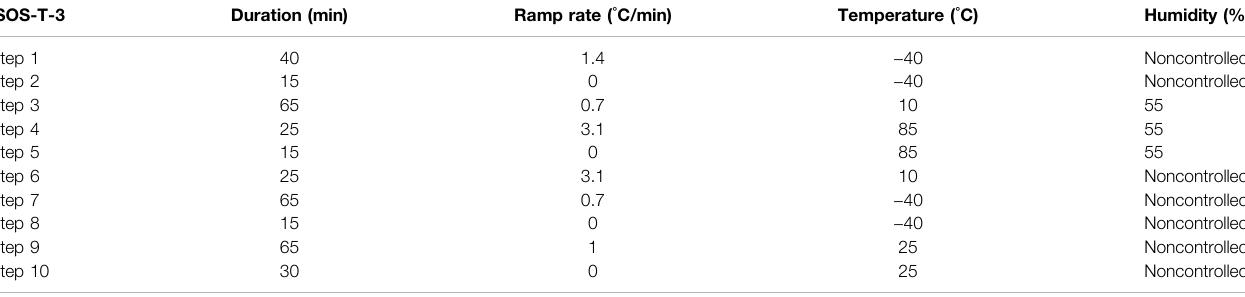
TABLE 3 | Cycle of thermal stress simulation using the Thermotron system to characterize the degradation process, complying with the ISOS-T-3 protocol. ISOS-T-3